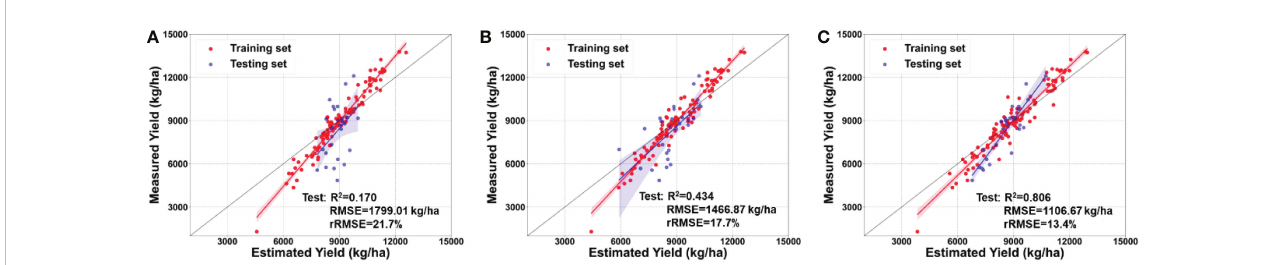
FIGURE 9 Estimation of maize yield by integrating multimodal data, but without considering the lodging index, at the (A) tasseling stage (VT), (B) milking stage (R3), and (C) denting stage (R5).